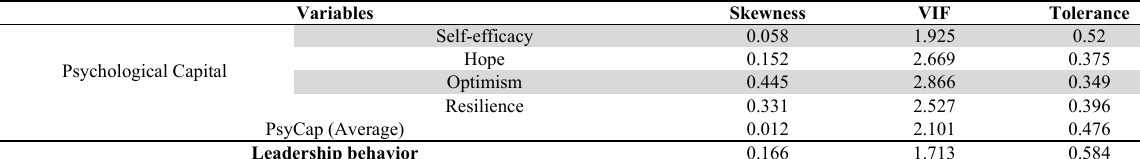
The suitability of study data to test hypotheses analysis using VIF test